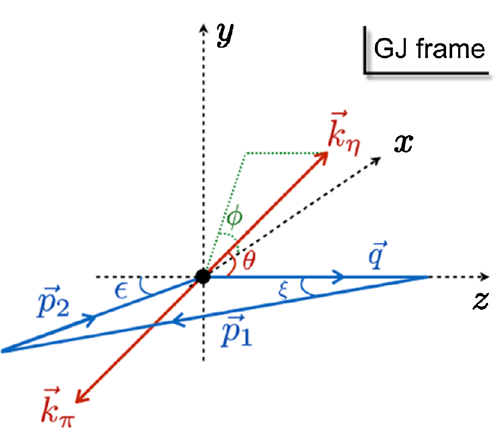
Fig. 25 GJ reference frame. See text in Appendix A for the definition of the variables and vectors